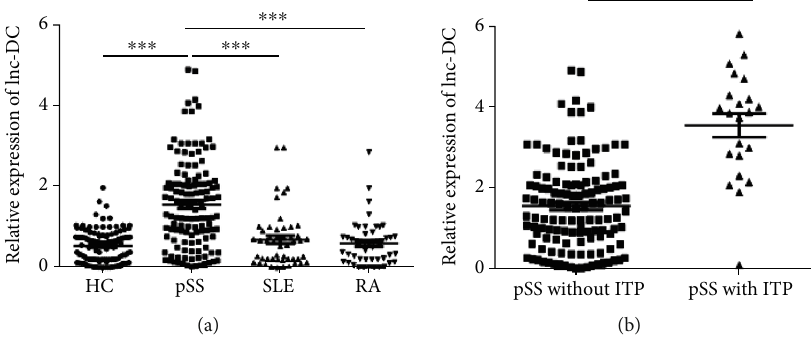
Figure 1: The relative expression of lnc-DC in HCs and pSS with or without ITP, SLE, and RA patients that was determined by qRT-PCR. ∗ P < 0 : 05 ; ∗∗∗ P < 0 : 001 , by one-way ANOVA with Bonferroni ’ s test and 2-tailed unpaired t -test. Table 1: The basic characteristics, clinical manifestations and laboratory fi ndings of pSS patients with and without ITP. Characteristic pSS without ITP ( n = 127